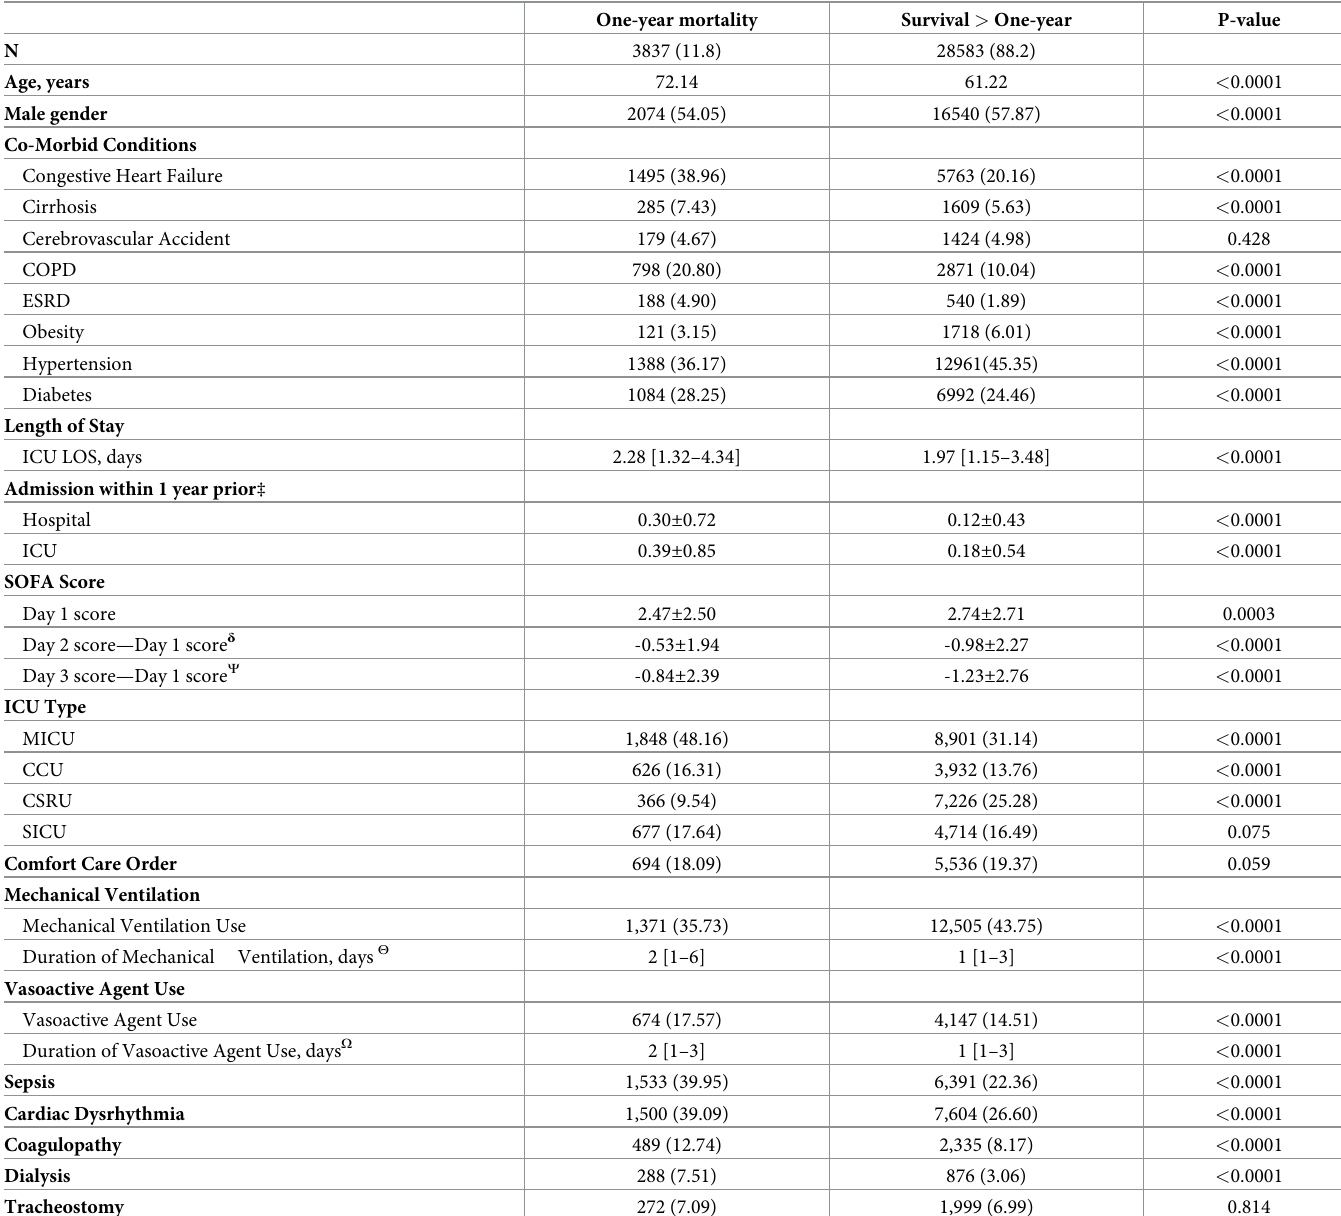
Table 1. Comparison based on length of survival (cid:3)